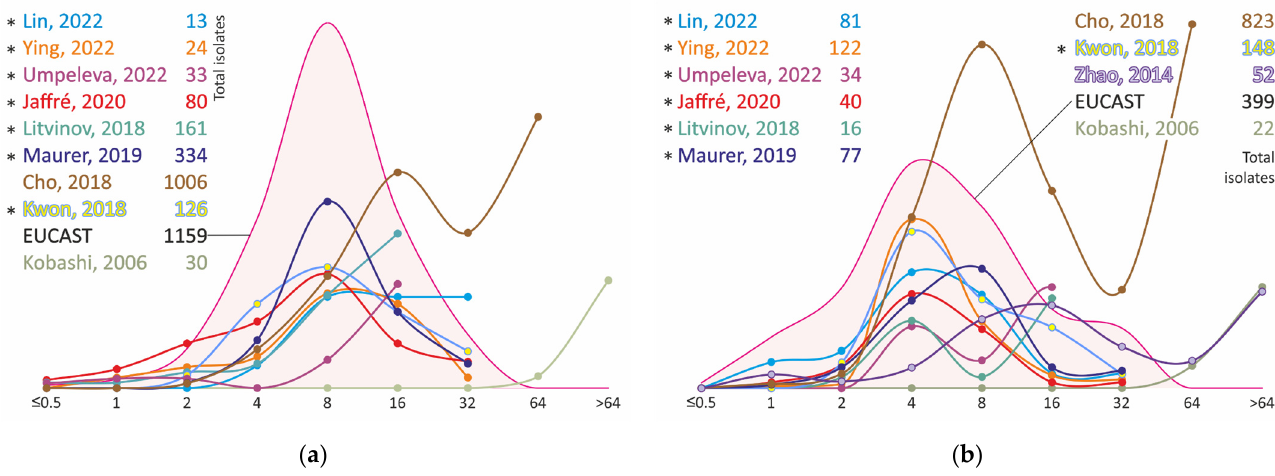
Figure 2. Ethambutol MIC distribution for clinical isolates of M. avium ( a ) and M. intracellulare ( b ). * MIC obtained using Sensititre SLOMYCO plates.